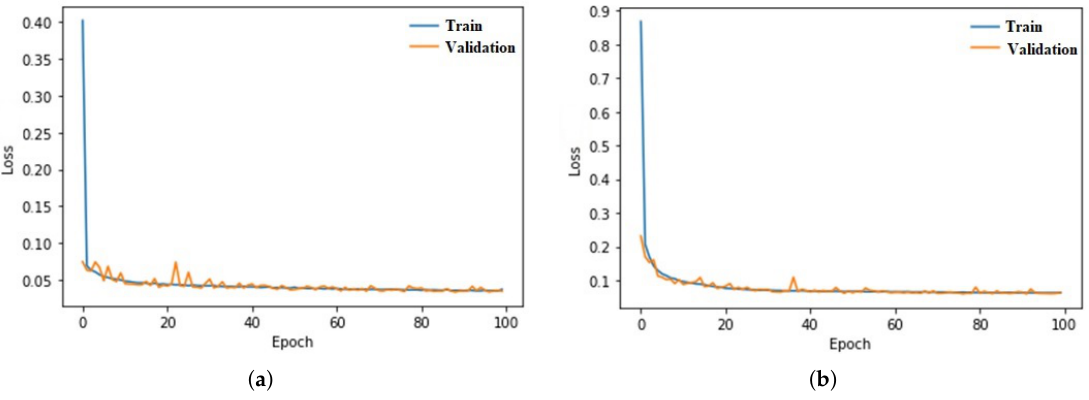
Figure 18. MLP neural network learning curves: scenario 3. ( a ) Ground training. ( b ) Non-ground